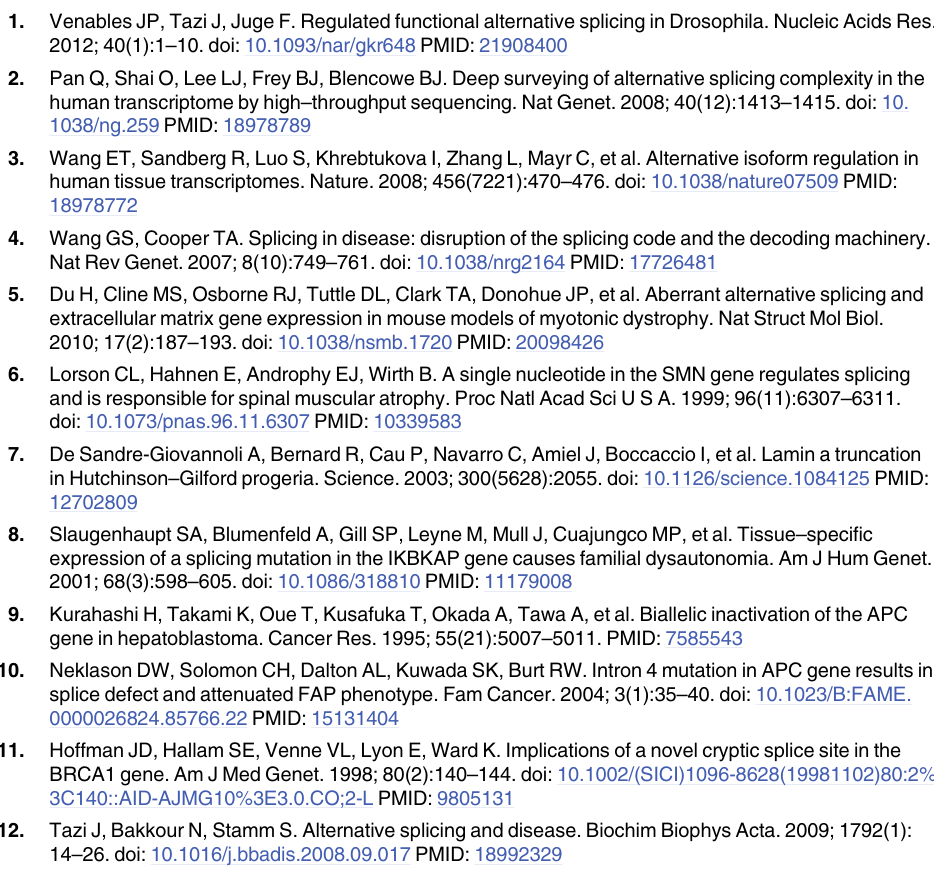
S1 Fig. Heat map of GO biological processes in relation to genes containing tissue restricted splice junctions. Plotted are relationship values from text-mining for top 5 GO bio- logical processes for each tissue after normalization and background